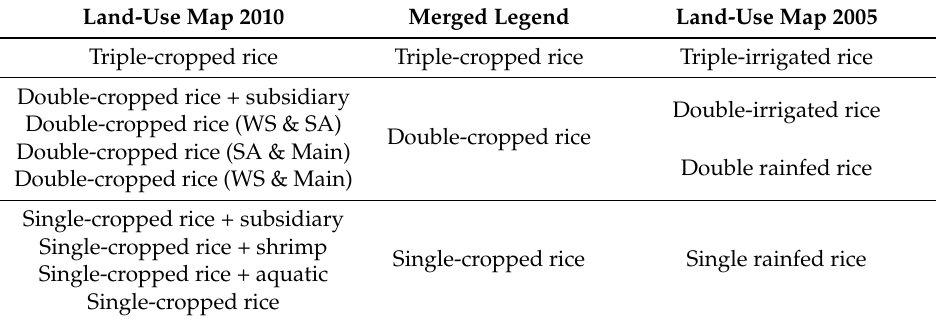
Table 1. Land-use map homogenization